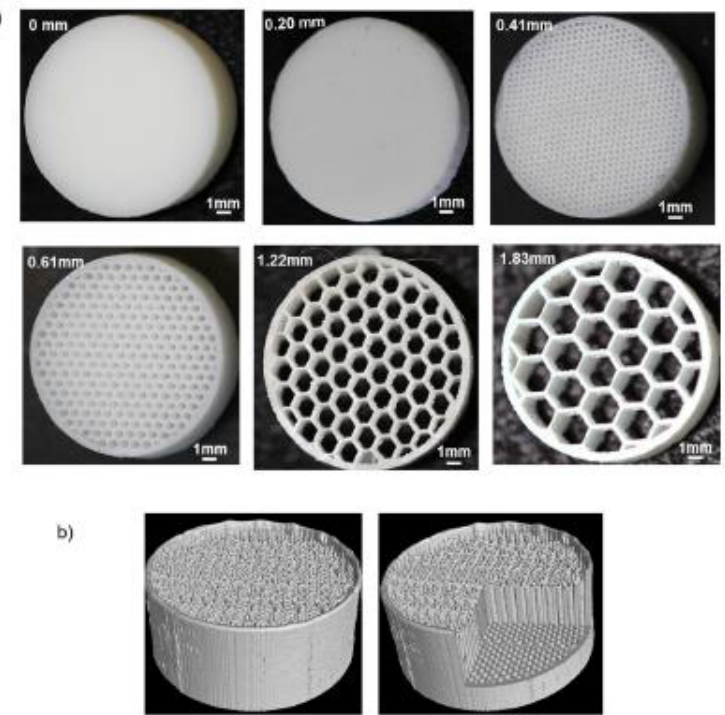
Figure 7. ( a ) Photographs of the printed solid tablet and honeycomb-like tablets with varying cell sizes between 0.20 mm and 1.83 mm; ( b ) 3D micro X-ray computed tomography ( µ CT) scan images obtained for the honeycomb architecture tablets, the right hand image has a digital cut-away (from Kyobula et al. [60], with permission).